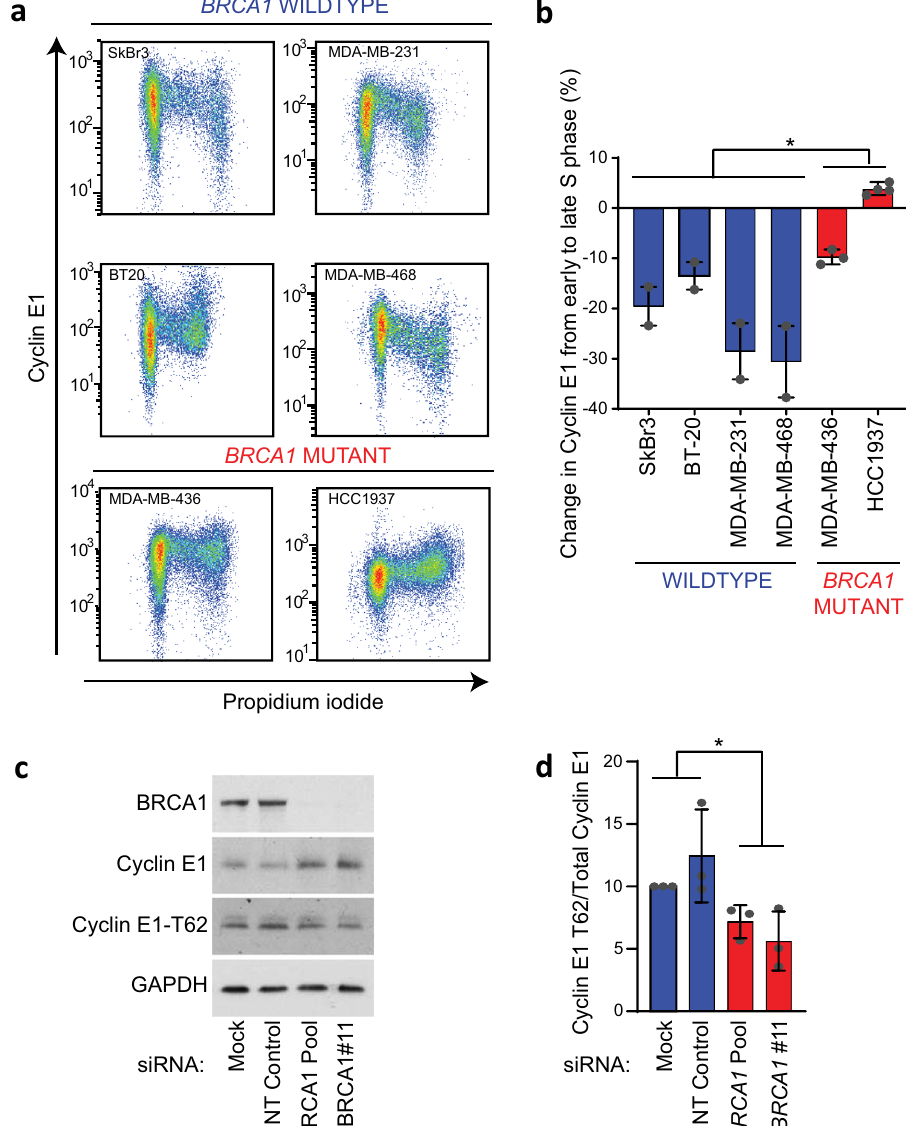
Fig. 3 Cyclin E1 protein is stabilized in the absence of functional BRCA1 . a Breast cancer cell lines (SkBr3, MDA-MB-231, BT-20, MDA-MB-468, MDA-MB-436 and HCC1937) were analyzed by fl ow cytometry for intracellular cyclin E1 and DNA content (propidium iodide). b Quantitation of fold change in expression of cyclin E1 from early S phase to late S phase as measured by fl ow cytometry in ( a ) of 2 – 4 replicates. Data are mean ± s.e.m., analyzed by t -test; * p = 0.05. c MDA-MB-468 cells were treated with siRNAs for 96 h (siRNAs: NTP (non-targeting pool) BRCA1 #11 and BRCA1 pool), and lysates western blotted for BRCA1, cyclin E1, cyclin E1 T62, and GAPDH. All blots derive from the same experiment and were processed in parallel. d MDA-MB-468 cells treated for 96 h with BRCA1 #11 siRNA, BRCA1 pool siRNA, and non-targeting pool siRNA were analyzed by densitometry and the ratio of cyclin E1 T62 to cyclin E1 expression determined from triplicate western blots. Data are mean ± s.e. m., analyzed by t -test; * p < (Fig. 6a). In the BRCA1 R1443* mutant PDX, single agent olaparib led to reduced tumor burden and increased overall survival (Fig. 6b – d).